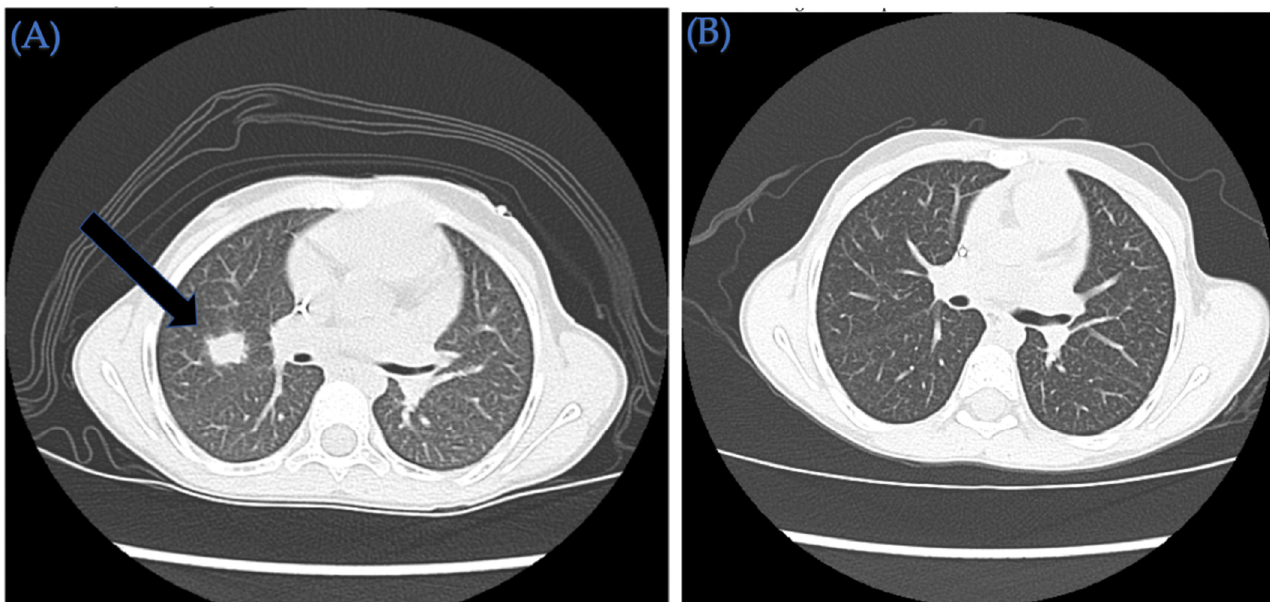
Figure 2. Computed tomography (CT) chest imaging of a 6-year-old Hispanic patient with relapsed AML. ( A ) Pre-HSCT CT chest indicates a 0.8 × 0.6 cm right upper lobe pulmonary nodule (arrow), a 0.6 cm right lower lobe lung nodule, and 0.4 cm left upper lobe pulmonary nodule. ( B ) Post-HSCT CT chest indicates resolving post-infectious nodules with no evidence of active infection.